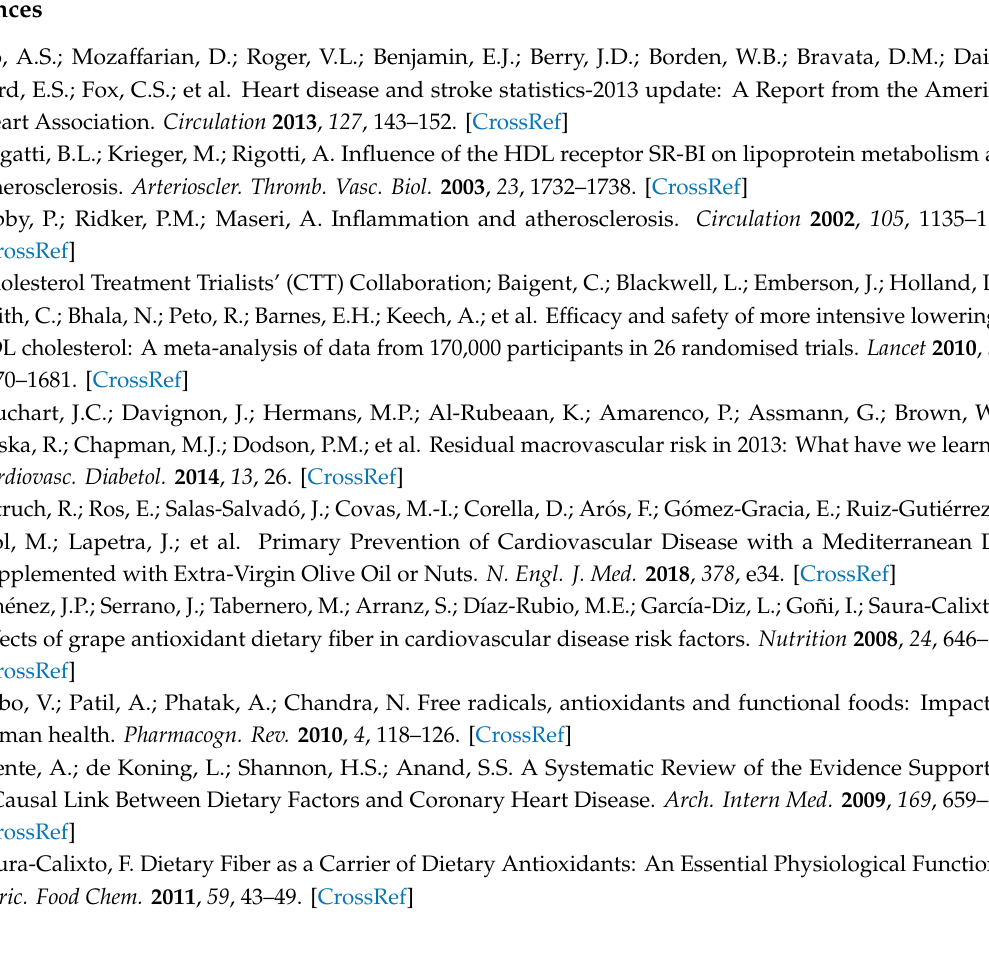
Table S1: Nutritional composition of RWGP flour and isolated oat fiber 780. Figure S1: E ff ect of RWGP supplementation on body weight of atherogenic diet-fed SR-B1 KO / ApoER61 h / h mice. Figure S2: E ff ect of RWGP supplementation on spleen and liver weights of atherogenic diet-fed SR-B1 KO / ApoER61 h / h mice. Figure S3: E ff ect of RWGP supplementation on plasma liver enzymes in atherogenic diet-fed SR-B1 KO / ApoER61 h / h mice. Figure S4: Aortic arch of atherogenic diet-fed SR-B1 KO / ApoER61 h / h mice reconstructed from bright-blood MR acquisition. Author Contributions: Conceptualization: G.E., D.B., M.E.A., P.I. and A.R.; data collection and handling: